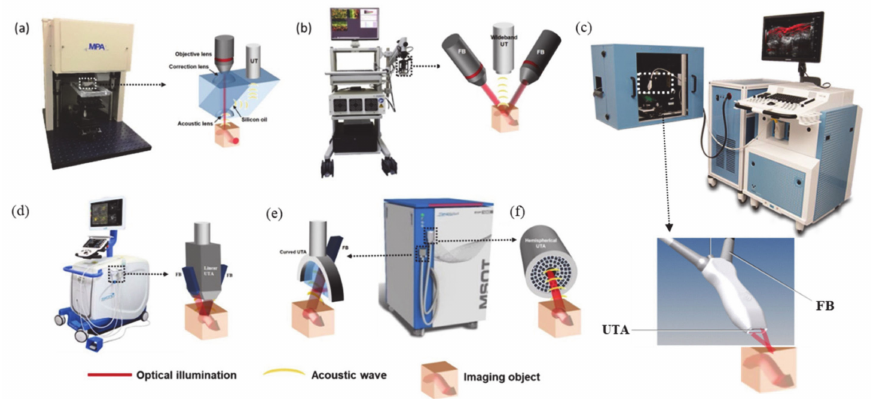
Figure 1. Commercially available photoacoustic imaging (PAI) systems along with the schematic depiction of imaging procedures: ( a ) Optical resolution photoacoustic microscopy, ( b ) Raster-scanning optoacoustic mesoscopy (RSOM), and ( c , d ) photoacoustic tomographic imaging devices equipped with linear ( e ) curved and ( f ) spherical transducer designs. (FB: fiber bundle; UTA: ultrasound transducer array). Adapted from Reference [10] under creative commons